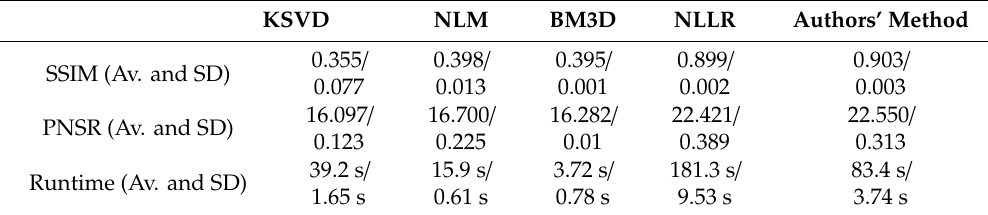
Table 5. The average (Av.) and standard deviation (SD) of indexes.